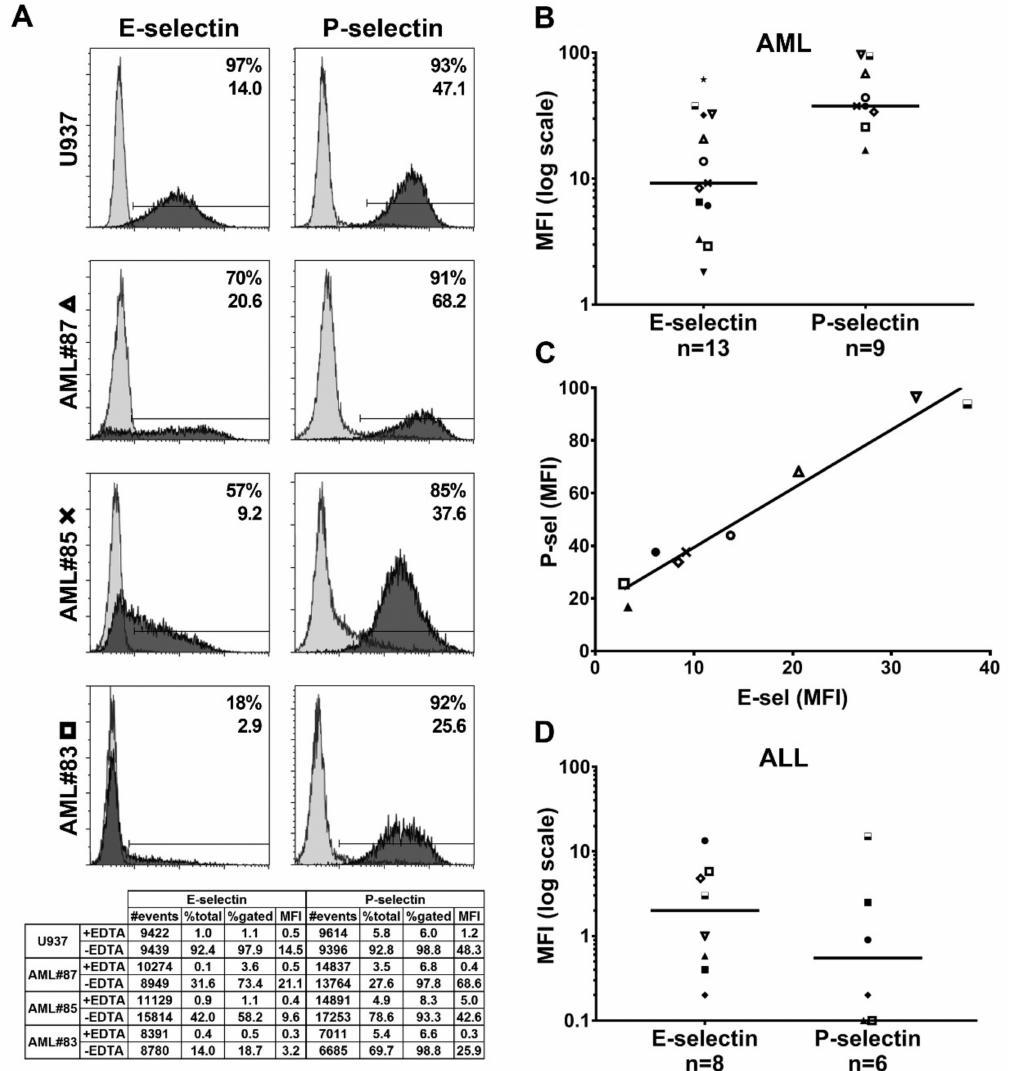
Figure 3. Primary myeloblasts and lymphoblasts express various levels of functional endothelial selectin ligands. ( A ) Flow cytometry histograms representative of high to low expression levels of functional